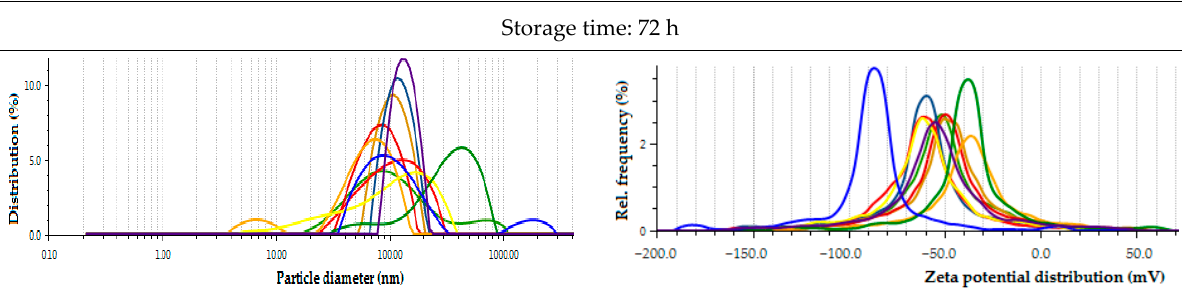
Figure 7. Zeta potential and hydrodynamic particle diameter of biosynthesized AgNPs depending on the time of incubation (30 min, 24 h, 72 h). Conditions: the ratio of 1 mM AgNO 3 to extract was 30:2 ( v / v ). Legend: Camellia sinensis (light red), Ilex paraguariensis (dark orange) , Salvia officinalis (yellow) , Tilia cordata (dark green) , Levisticum officinale (dark blue) , Aegopodium podagraria (light green) , Urtica dioica dark red) , Capsicum baccatum (light blue) , Viscum album (light orange), and Porphyra Yezoensis (violet).